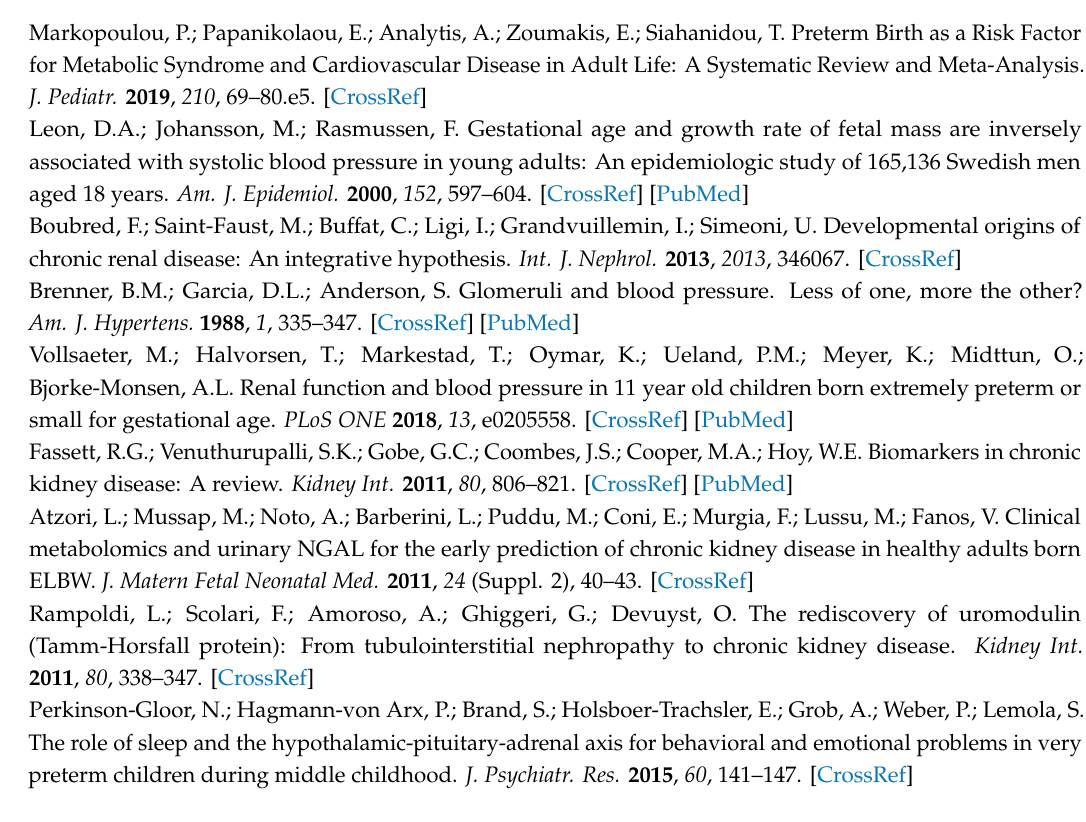
Table S1: Methods for analyzing renal biomarkers in serum and urine. Table S2: Characteristics of subgroups within the preterm born and term born group according to which, if any, samples were provided by the study